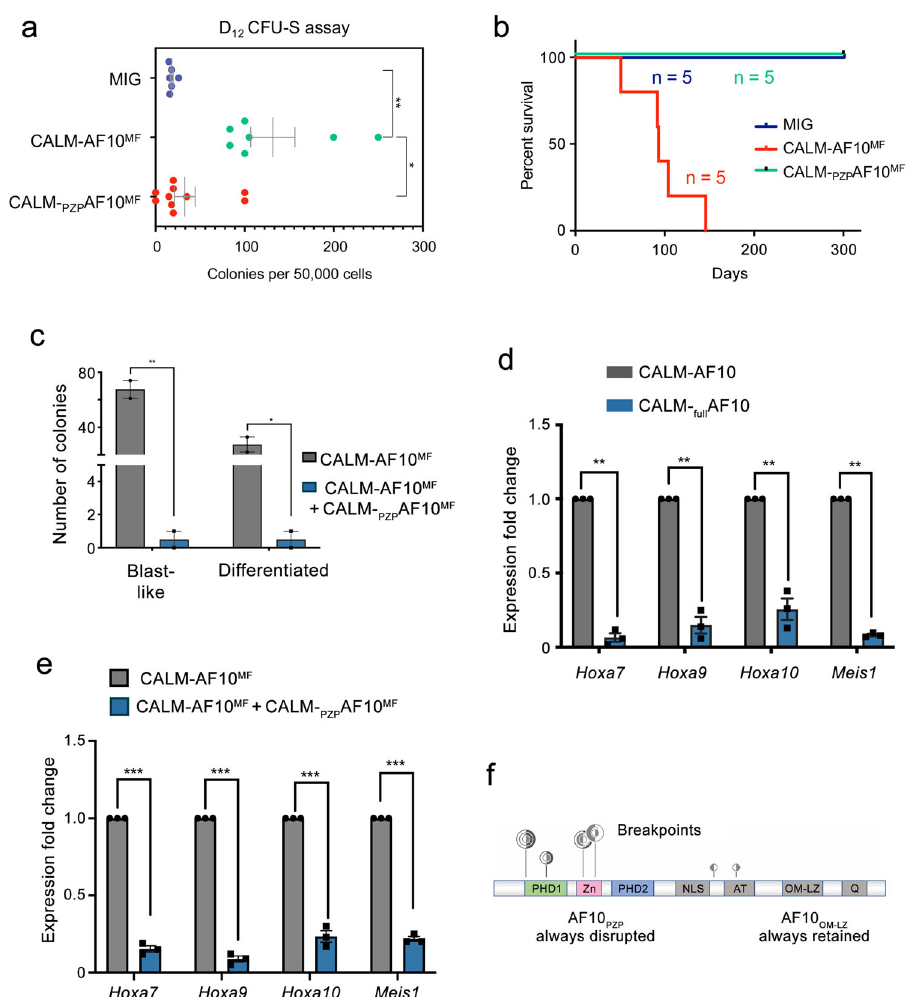
Fig. 2 AF10 PZP impairs in vivo leukemic activity of CALM-AF10. a The number of day-12 (D12) colony-forming units in the spleen (CFU-S) enumerated per 50,000 cells from mice injected with each of the indicated constructs are shown. ** P value of 0.0015 and * P value of 0.04 (two tailed Student ’ s t -test) and data presented as mean + / − SEM. b Kaplan Meier plot showing survival of mice injected with bone marrow-derived HSPCs transduced with MIG (vector), CALM-AF10 MF, or CALM- PZP AF10 MF is shown. P value of signi fi cance between CALM-AF10 MF and CALM- PZP AF10 MF < 0.001 (Log-rank t -test). c Number of colonies per 1000 cells with blast-like or differentiated morphology in CALM-AF10 MF leukemia cells or the same cells transduced with the CALM- PZP AF10 MF fusion are shown. ** P value = 0.009 and * P value = 0.03. data are presented as mean + / − SEM from one representative experiment ( n = 3). d q-RT PCR analysis of expression of Hoxa7 , Hoxa9 , Hoxa10 , and Meis1 in CALM- full AF10 transduced murine bone marrow cells shown as fold change relative to expression of these genes in CALM-AF10 expressing cells. *** P value = 0.0003 (two-tailed student ’ s T -test) and data are presented as mean + / − SEM from one representative experiment ( n = 3). e q-RT PCR analysis of expression of leukemia-associated Hoxa cluster genes and Meis1 in CALM-AF10 MF cells expressing CALM- PZP AF10 MF shown as a fold-change relative to expression of these genes in CALM-AF10 MF